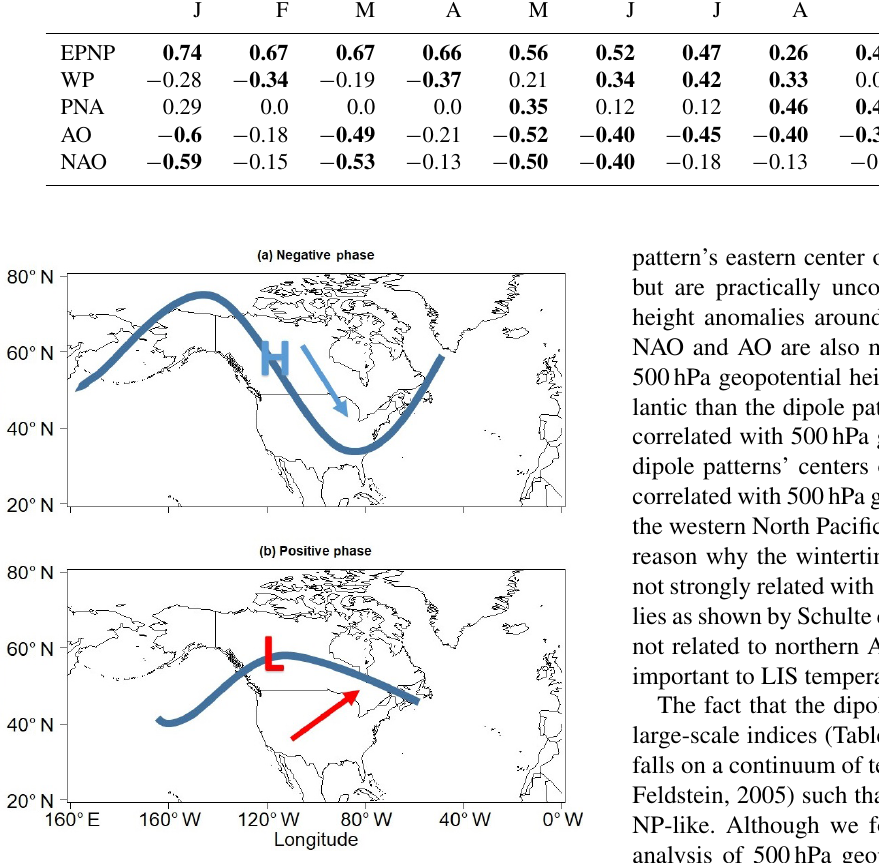
Figure 5. (a) Idealized schematic of atmospheric features occur- ring during negative LIS temperature events and negative phases of the dipole pattern. (b) Same as (a) but for positive LIS temperature events and positive phases of the dipole pattern. Thick blue curves represent the idealized jet stream configuration, while the blue (red) arrow indicates the general movement of cold (warm) air masses. High pressure is indicated with an H and low pressure is indicated with an L